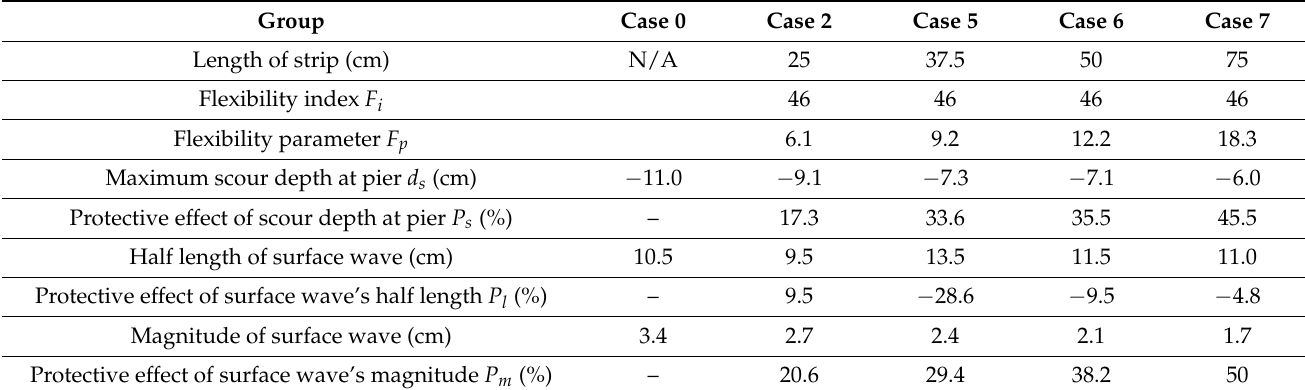
Figure 15. Change of centerline with CKAW with different lengths of strips. Table 5. Protective effect with different lengths of